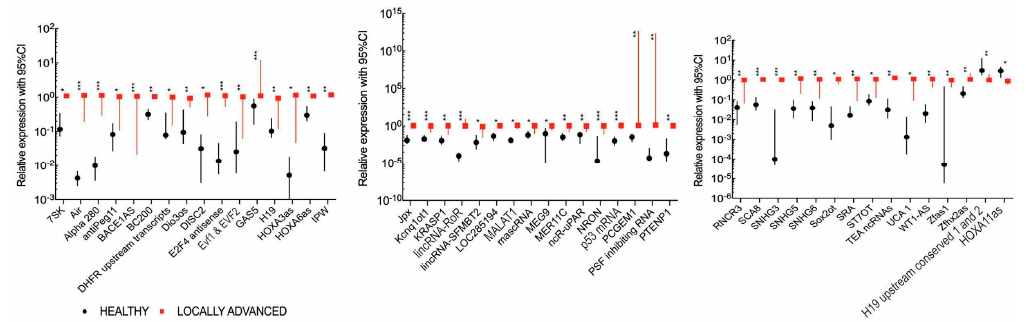
Figure 3. Significantly changed ( p < 0.05) expression levels of 47 plasma lncRNAs between healthy volunteers (black) and locally advanced HNSCC patients (red). Squares and circles represent the mean of expression and lines indicate 95% CI; * p < 0.05, ** p < 0.01, *** p < 0.001.